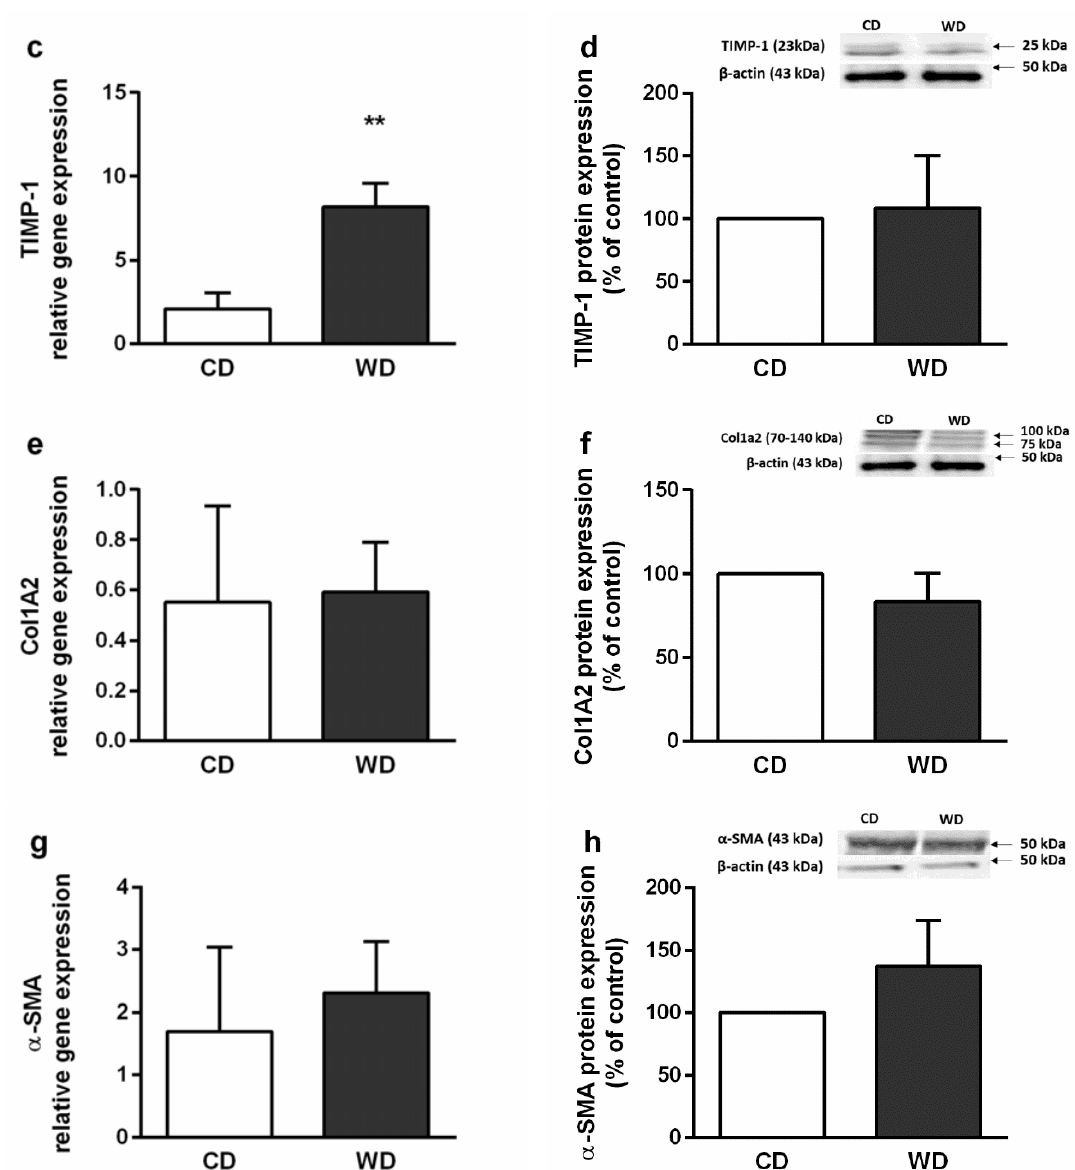
Figure 5. Markers of hepatic fibrosis and stellate cell activation in mice fed a control diet (CD) and a Western-style diet (WD). ( a ) Tumor growth factor beta (TGF- β ) gene and ( b ) TGF- β protein expression. ( c ) Tissue inhibitor of metalloproteinase-1 (TIMP-1) gene and ( d ) TIMP-1 protein expression. ( e ) Collagen type I alpha 2 chain (Col1A2) gene and ( f ) Col1A2 protein expression. ( g ) Alpha smooth muscle actin ( α -SMA) gene and ( h ) α -SMA protein expression. The results are expressed as the means ± SD; ** p < 0.01 ( n = 4–5 each group). Representative Western blot images are shown in graphs.